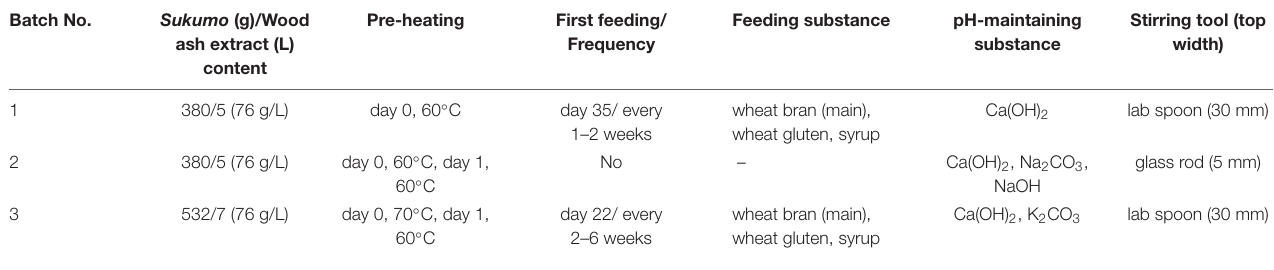
TABLE 1 | Preparation and maintenance procedures for three batches of Japanese indigo fermentation fluids. Batch